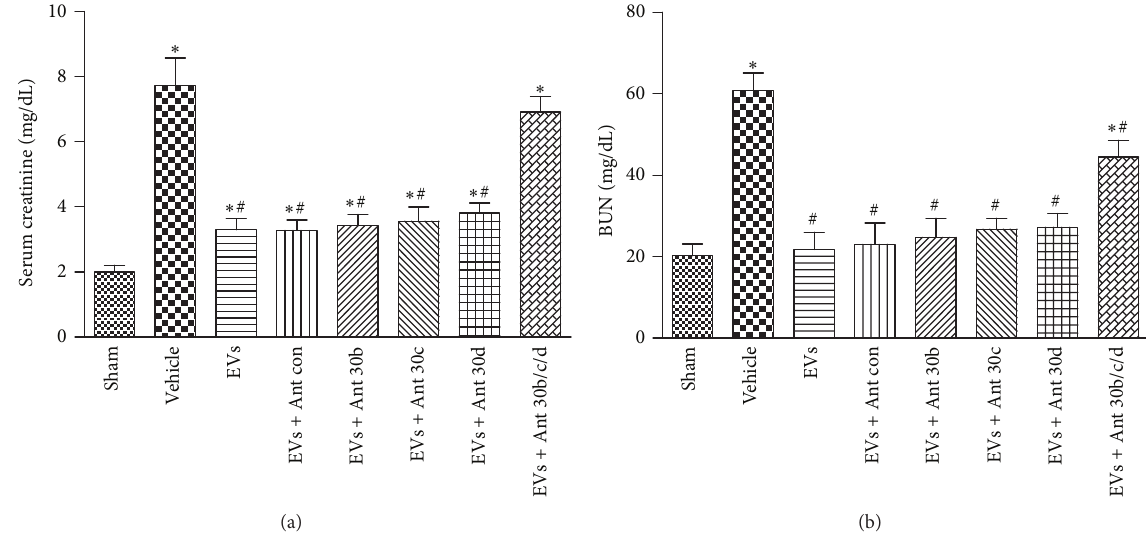
Figure 5: Protective effect of EVs in renal function. (a, b) Serum creatinine and BUN levels were measured at 24 h after injury in the sham, vehicle, EVs, and antagomir-treated EVs groups. Data in (a) and (b) are presented as mean ± SD; 𝑛 = 6 ; ∗ 𝑃 < 0.05 , versus sham; # 𝑃 < 0.05 , versus